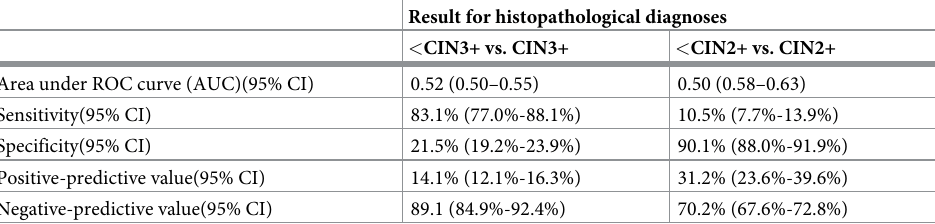
Table 8. Accuracy of management recommendation by the 2019 ASCCP guidelines in predicting cervical intrae- pithelial neoplasia. Result for histopathological